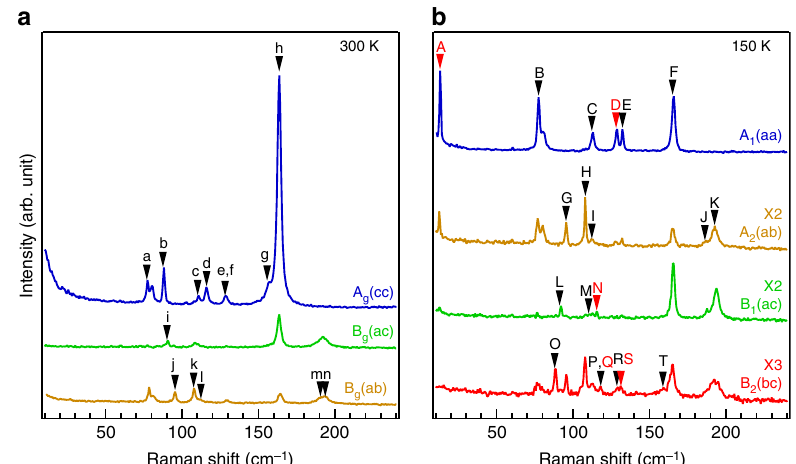
Figure 2 | Polarized Raman spectra measured in the high- and low-temperature phases. ( a , b ) Polarized Raman spectra measured at 300K ( a ) and 150K ( b ). The identified Raman peaks are labelled by lowercase (high-temperature phase) and capital (low-temperature phase) letters. The red labels A, D, N, Q and S mark the Raman modes that are directly sensitive to the inversion symmetry breaking. The small peak at 83cm (cid:2) 1 is from the instrument and not intrinsic to the